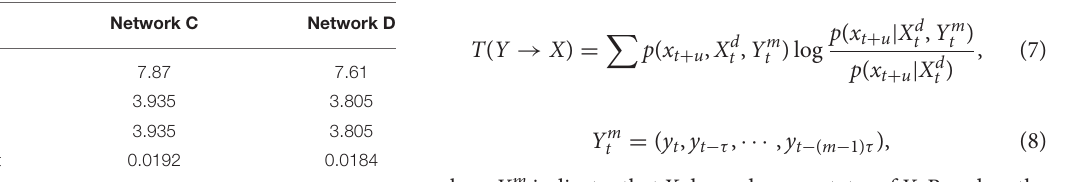
TABLE 3 | The Topological features of Network C and